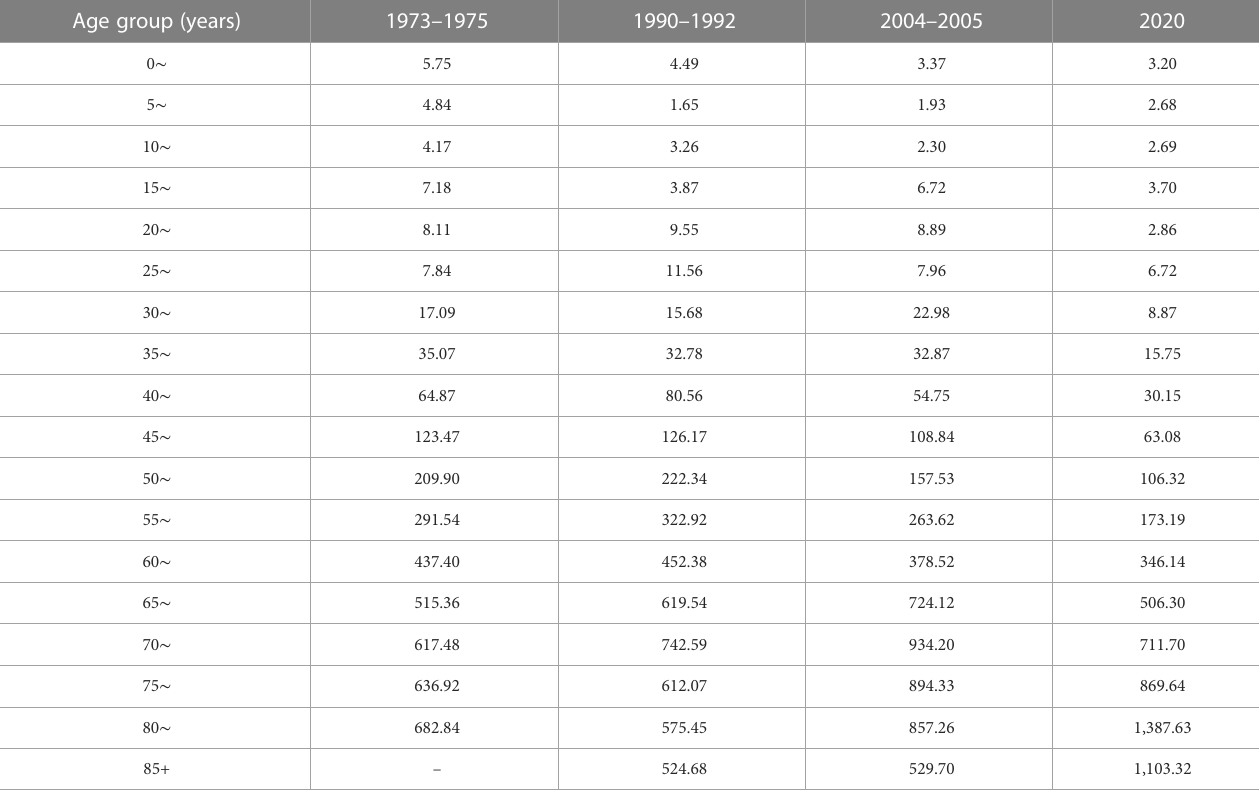
TABLE 1 Age-speci fi c mortality rates of cancer during four periods (1/10 5 ). Age group (years)